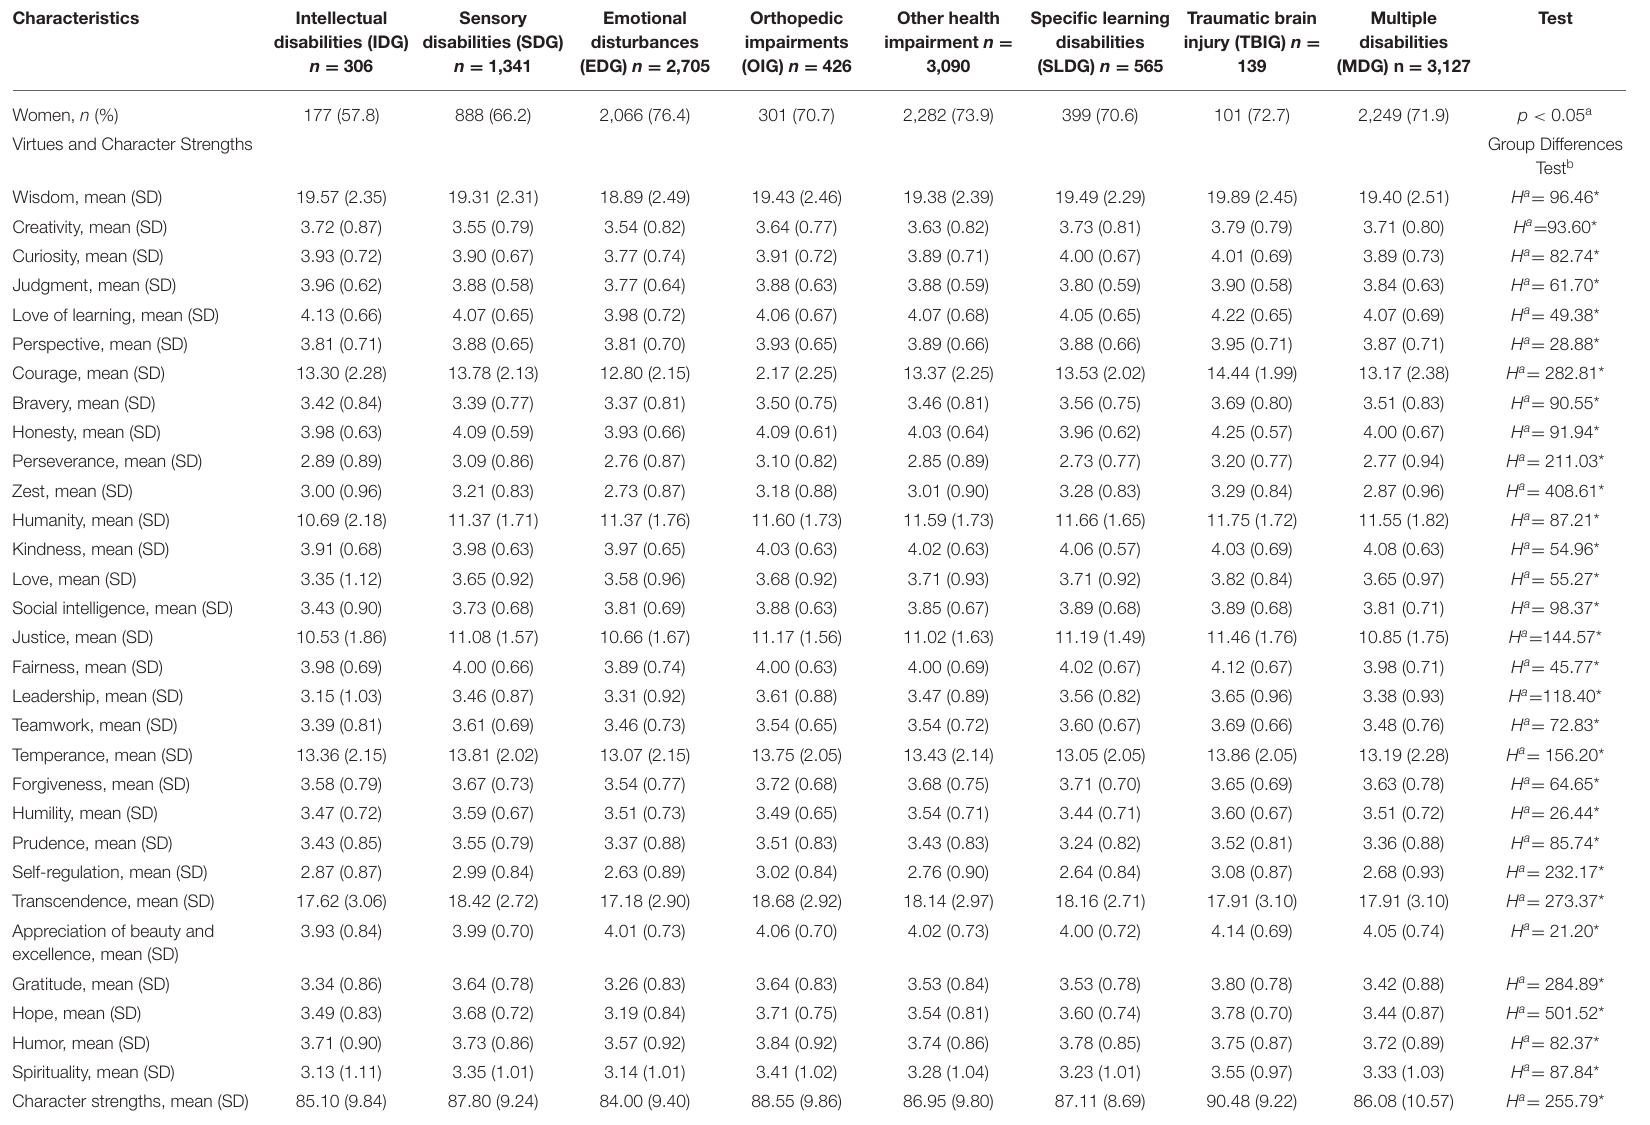
TABLE 1 | Demographic information and character strengths group characteristics and differences.